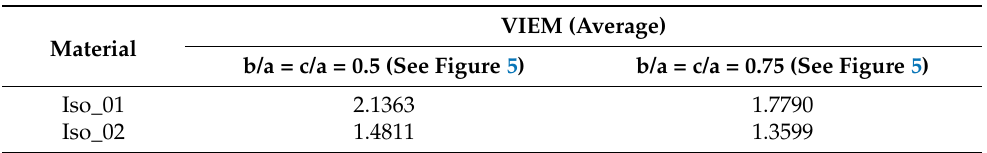
Figure 17. A typical discretized oblate spheroidal model (b/a = c/a = 0.75) in the volume inte- gral equation method (VIEM). ( a ) An inside view of an oblate spheroidal model. ( b ) An oblate spheroidal model. Table 14. Normalized tensile stress component ( σ xx / σ o xx ) within the isotropic oblate spheroidal inclusion due to uniform remote tensile loading ( σ o xx ).